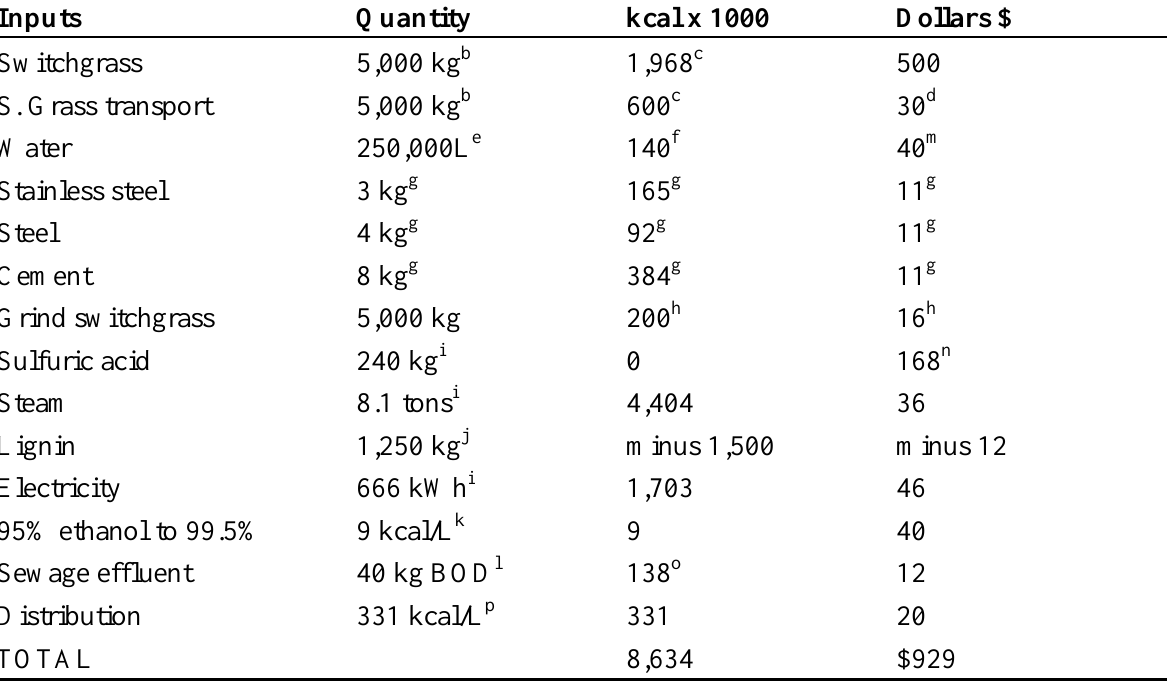
Table 7. Inputs per 1000 liters of 99.5% ethanol produced from U.S. switchgrass.